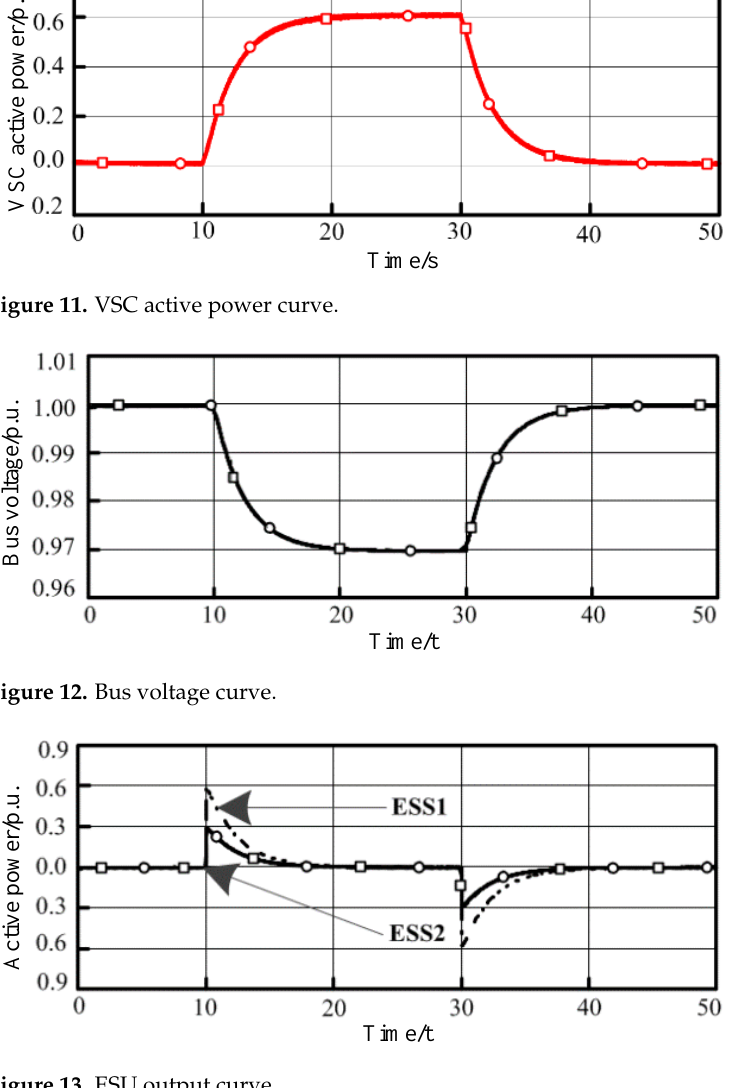
Figure 13. ESU output